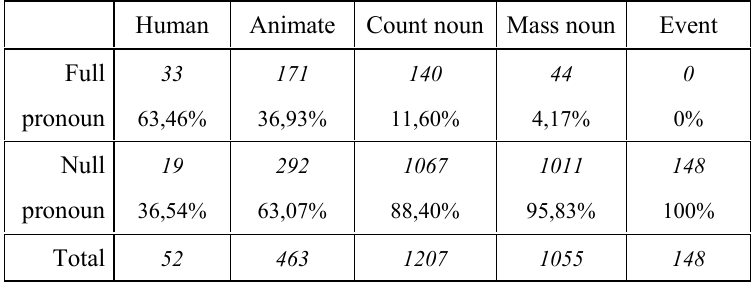
Table I: Pronominalization frequency: the animacy hierarchy Human